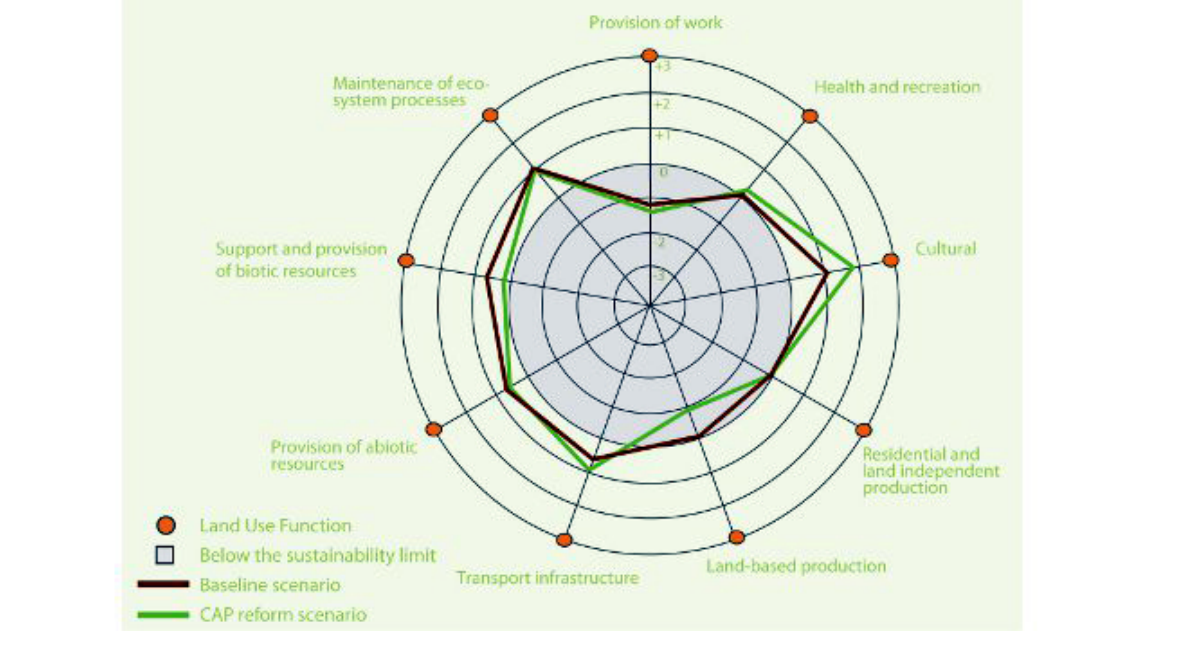
Fig. 8 . Common Agricultural Policy financial reform scenario: 100% cut of Common Agricultural Policy first pillar measures (market support and direct income support), and re-investment of savings in research and development. The image shows impacts on land-use functions in Jaén, a province in southern Spain, and the land-use function scores for baseline and Common Agricultural Policy reform scenarios in